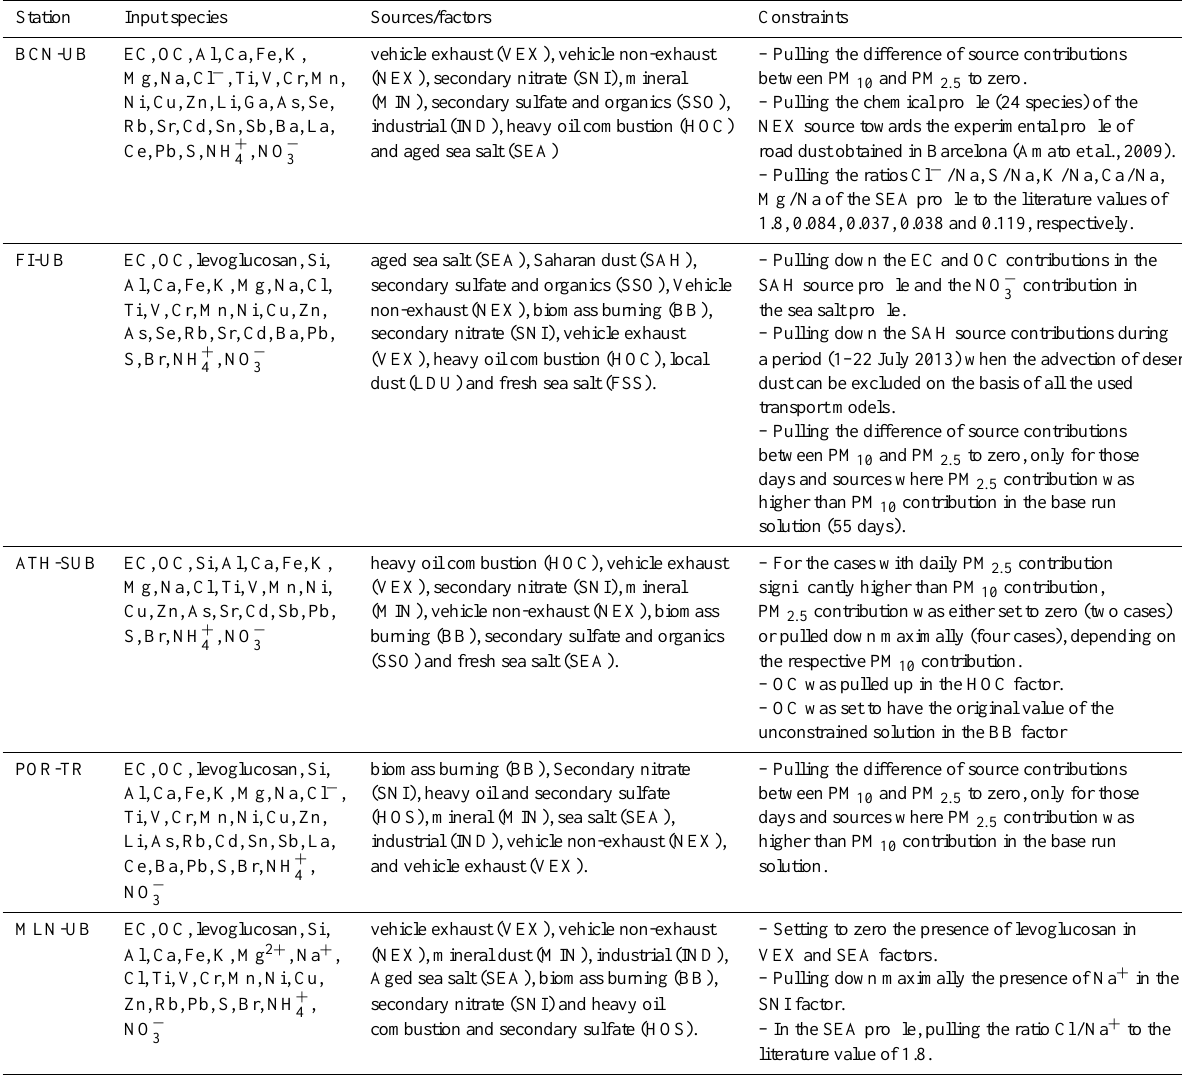
Table 2. Summary of input species, identified factors and constraints for city-specific PMF